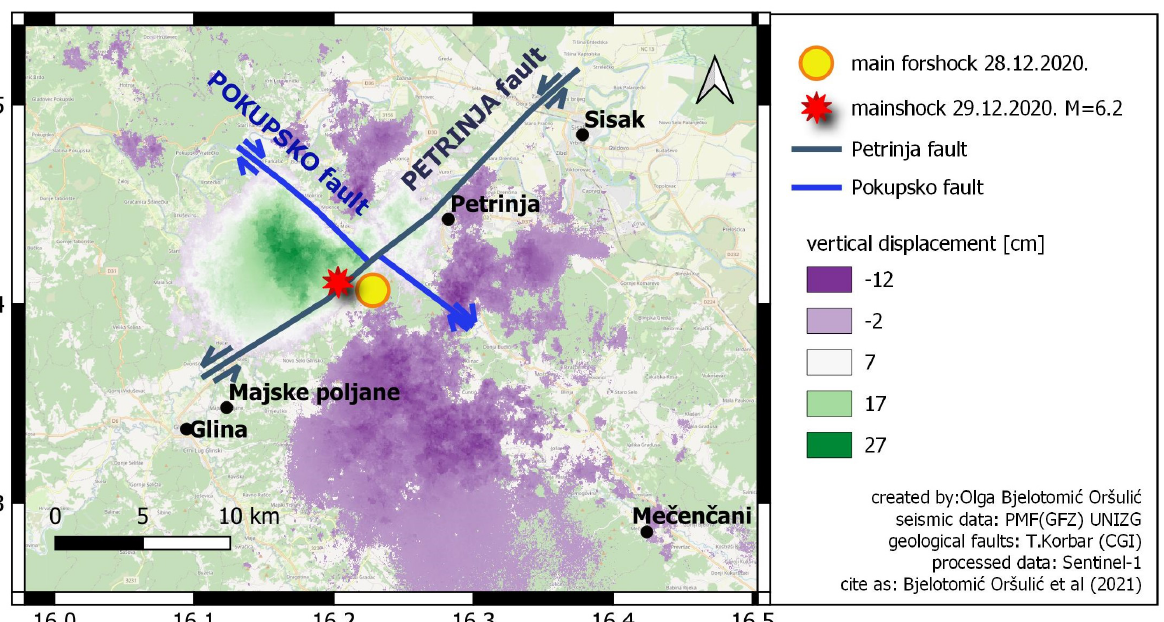
The vertical displacements range between − 12 cm and 22 cm stretching over the earthquake stricken area (see Figure 9). The spatial split between the land subsidence and the land uplift follows the directions of Pokupsko and Petrinja strike-slip faults mapped by Croatian Geological Institute [74]. Vertical displacement is mostly expressed in the western quadrant; on the other hand, the displacement across the faults themselves is minimal. However, we find the increased values of displacement on the western and southern quadrant relatively expected due to topography indented in that area. On other hand, in the northern and eastern quadrant, the displacement is lower than the topography regarding the faults of Pokupsko and Petrinja, but there is still a displacement range of topography also in a wider affected area. The results of the horizontal west–east displace- ment coincide with the recently published GNSS field measurements [75]. Comparing the results from [75] with the results of the SAR analysis, the ground displacements around the epicenter are the resultant vector of two identified strike-slip faults: Pokupsko and Petrinja, as seen in Figure 9.